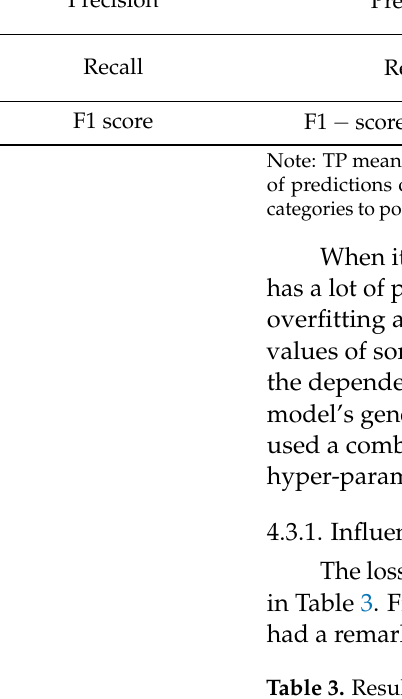
Table 3. Results of experiments based on